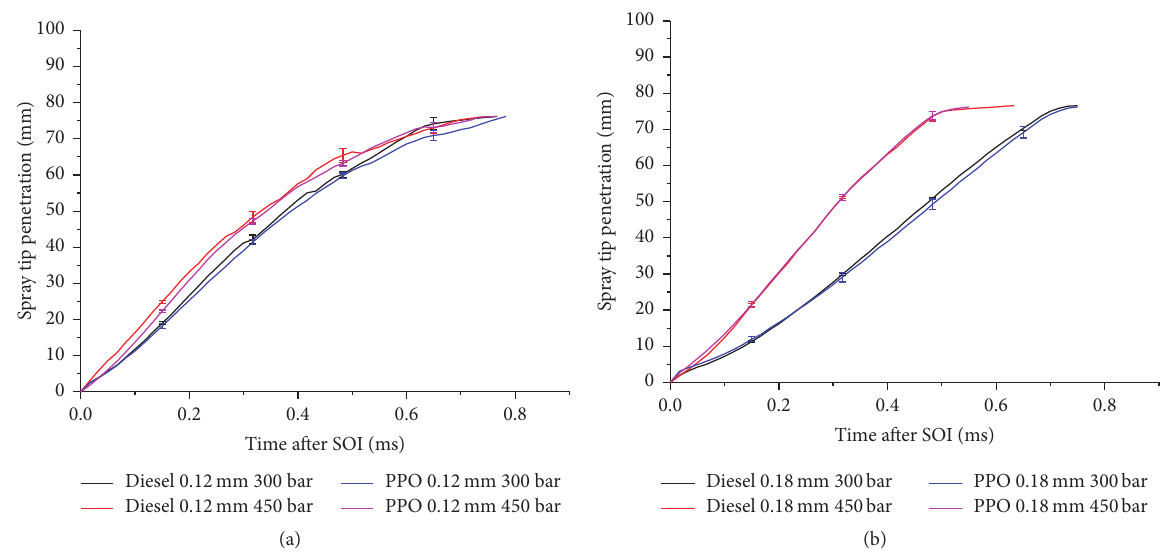
Figure 7: Variation of spray tip penetration with time for nozzle 0.12 mm (a) and 0.18mm (b).